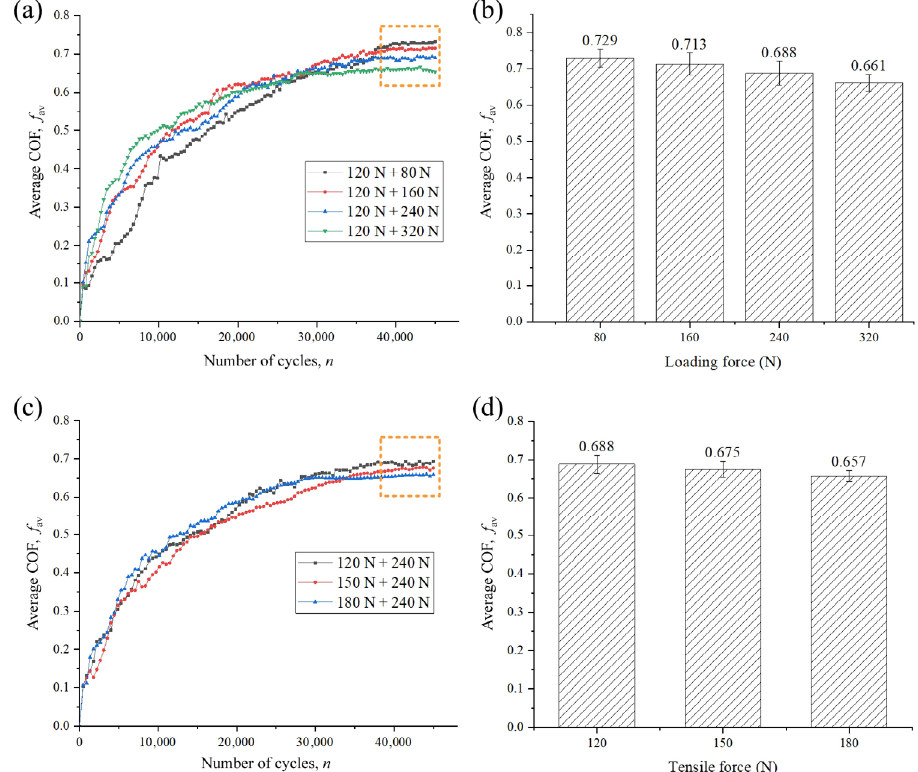
Fig. 8 COFs under the combined action of different wire tension and lateral